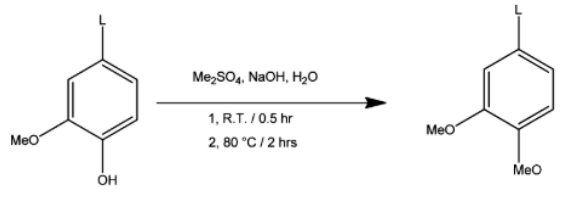
Figure 8. Methylation of kraft lignin by dimethyl sulfate in aqueous NaOH [90].